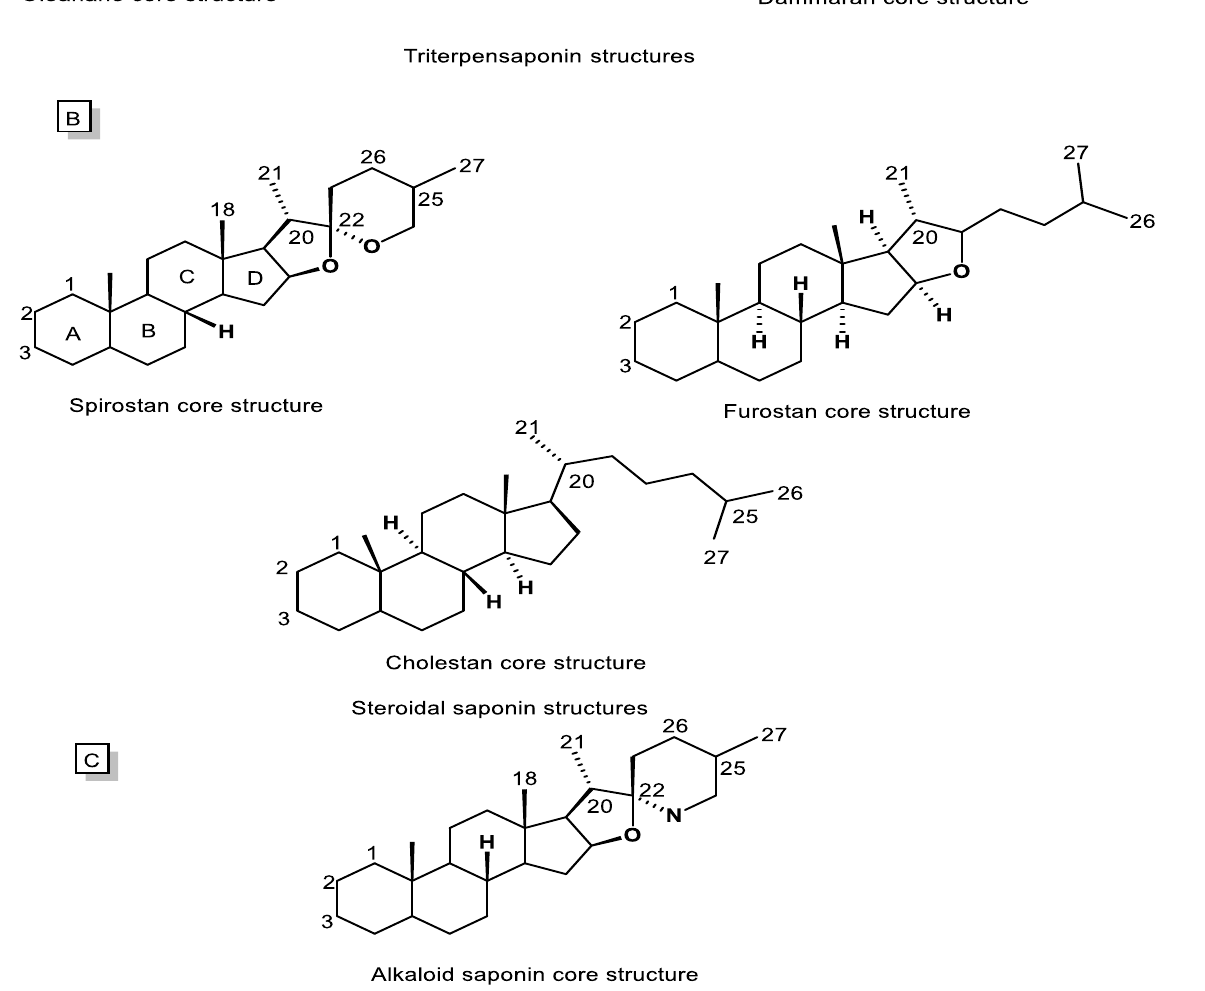
Figure 2. Chemical structures of saponin cores. ( A ) Triterpenoid saponins, ( B ) Steroidal saponins, and ( C ) Alkaloidal saponins.